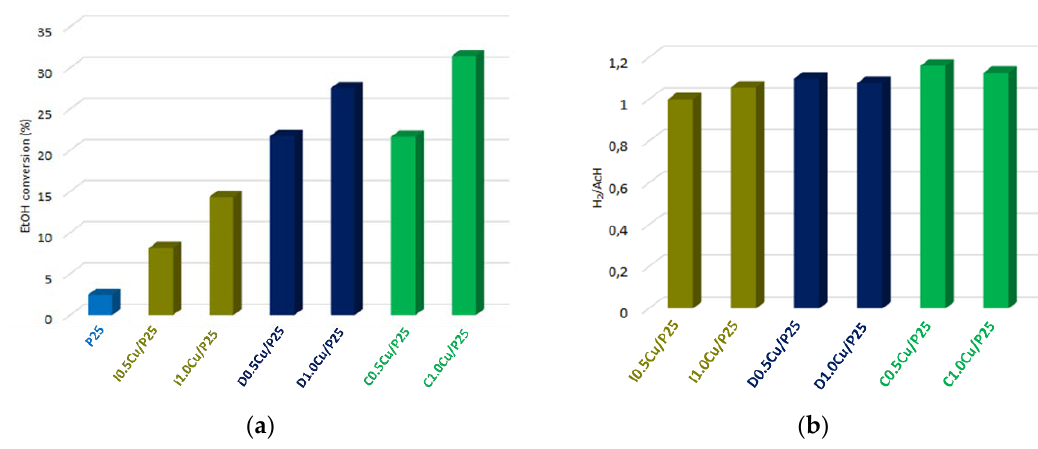
Figure 4. ( a ) Ethanol conversion on P25 and CuO-loaded P25 photocatalysts; ( b ) H 2 /AcH ratio on CuO-loaded P25 photocatalysts.